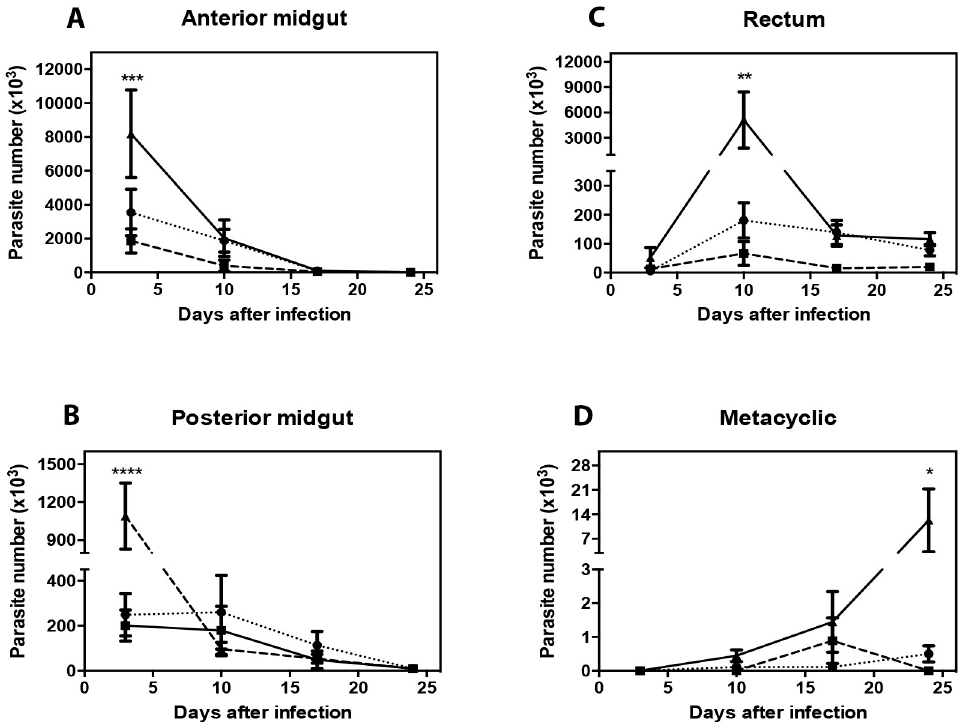
Fig 3. Effects of anticoagulants on Trypanosoma cruzi infection. Fifth instar nymphs were fed on blood collected with citrate (dotted line), EDTA (dashed line), or heparin (continuous line) as anticoagulants containing 10 7 parasites/mL. The infection profile was obtained by counting the parasite numbers in the anterior midgut (A), posterior midgut (B), and rectum (C). The number of metacyclic trypomastigotes was measured in the rectum (D). Statistical analysis: two- way ANOVA, followed by Bonferroni test, Total number of insects observed N citrate 9, N EDTA 9, N Heparin 9. � P < 0.05; �� P < 0.01; ��� P < 0.001; ���� P < 0.0001.